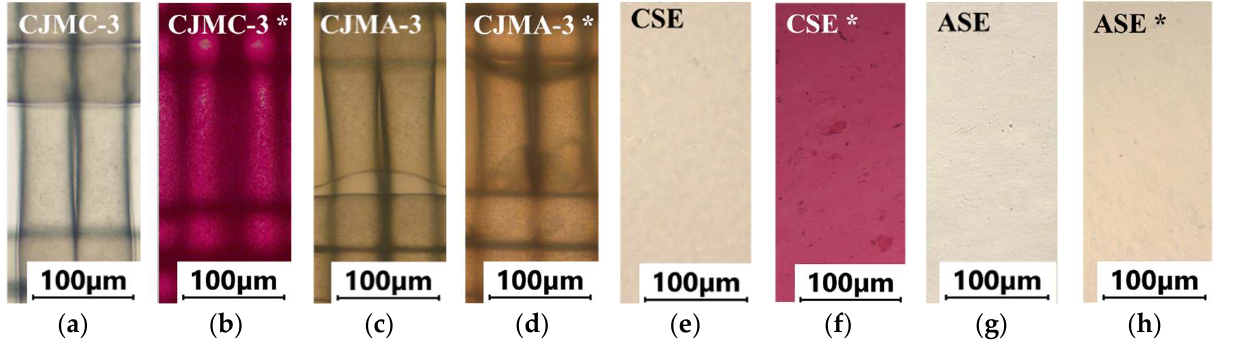
Figure 4. Optical images of membranes surfaces facing the desalination compartment. Membranes after electrodialysis processing of model solution ( b , d , f , h ) are indicated by *. Images of pristine membranes in distilled water ( a , c , e , j ) are shown for comparison.